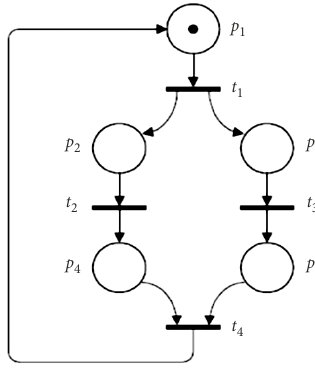
Figure 5. Initial marking of the Petri net ( m